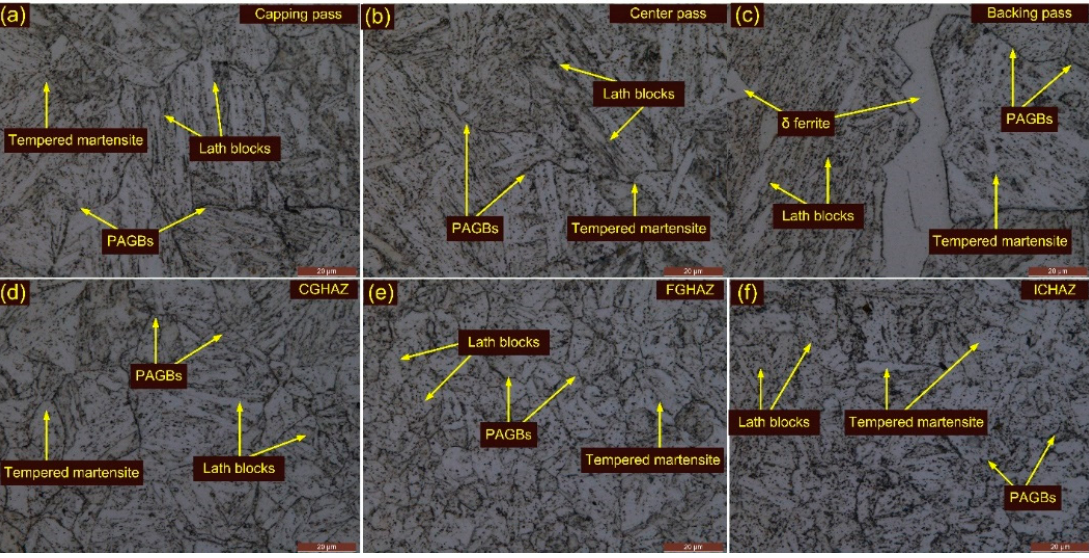
Figure 9. Weldments after T1 treatment: WFZ ( a ) capping pass, ( b ) center pass, ( c ) backing pass; ( d ) CGHAZ, ( e ) FGHAZ, ( f ) ICHAZ.